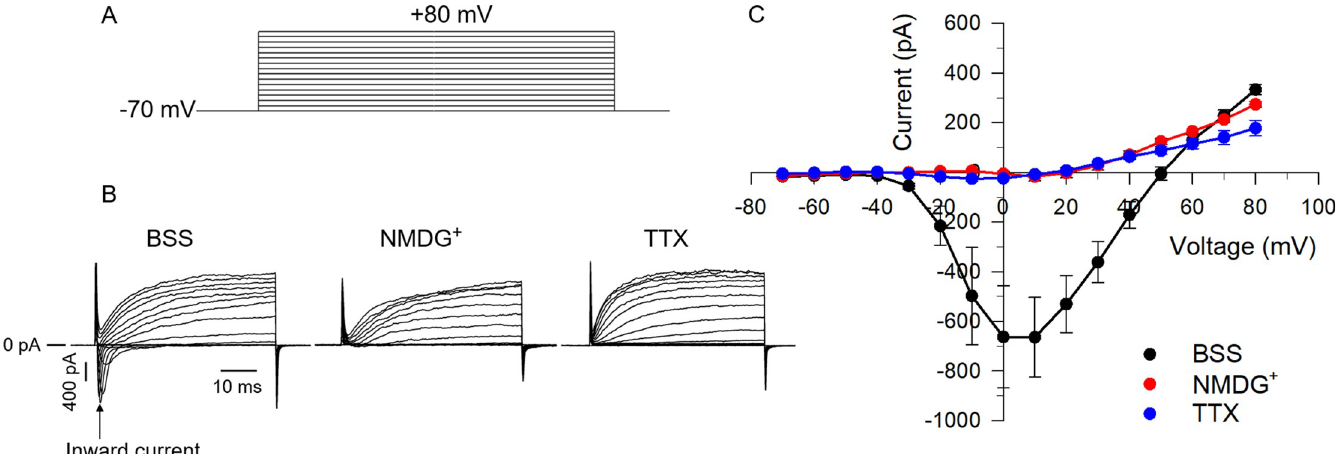
Fig 1. Voltage-dependent properties of the early inward current recorded in whole-cell voltage clamped bovine chromaffin cells. (A) The voltage clamp step protocol used to determine the voltage-dependence of peak inward current consisted of 50 ms steps ranging from –70 to +80 mV, applied in 10 mV increments every 2 s from a holding potential of –70 mV. (B) Representative families of membrane current traces elicited by the voltage step protocol shown in (A) recorded in different experimental conditions. BSS: normal K + -based external bath solution; NMDG + : an equimolar concentration of NMDG + was used to replace Na + in the external bath solution; TTX: 5 μ M TTX was added to the BSS to block voltage-dependent Na + channels. (C) I-V relationship for the peak inward current (arrow in B). Each data point represents the mean value ± SE (BSS, n = 4; NMDG + , n = 6; TTX, n = 3).